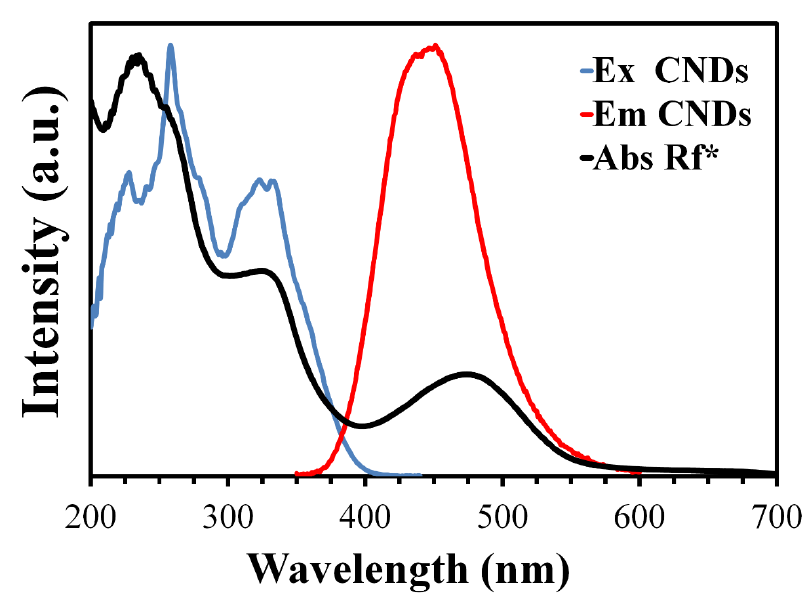
Figure 6. Absorption spectra of rifampicin, and the excitation and emission spectra of the CNDs . Rf* stands for rifampicin.